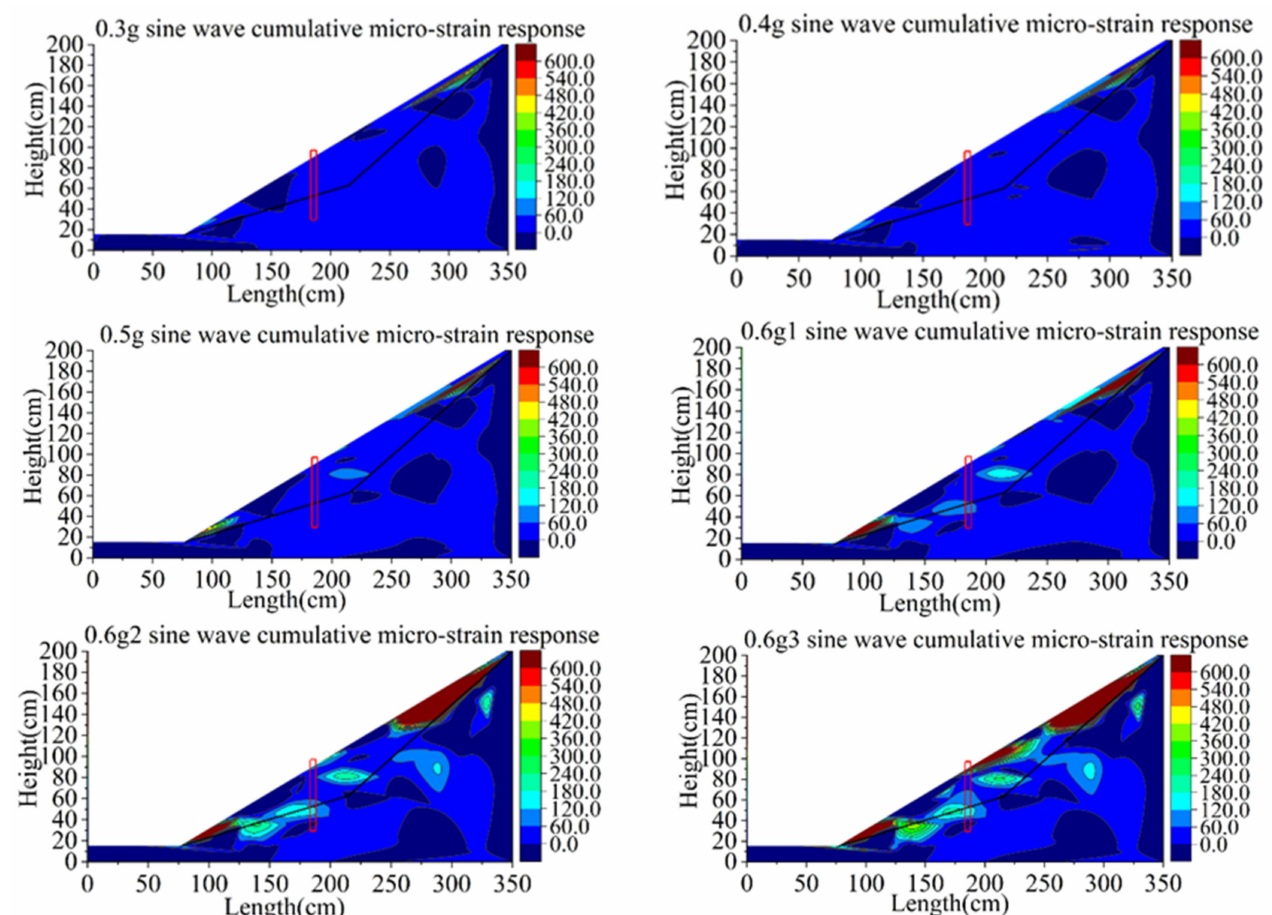
Figure 19. Contours of shear strain response of model B (unit: µε